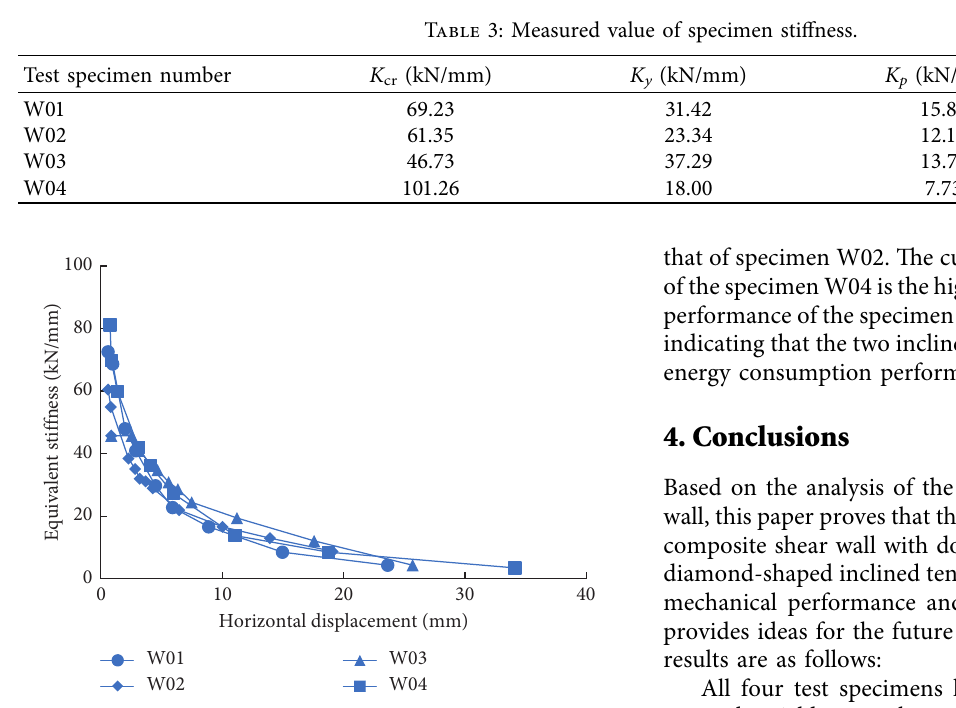
Figure 9: Equivalent stiffness degradation curve.